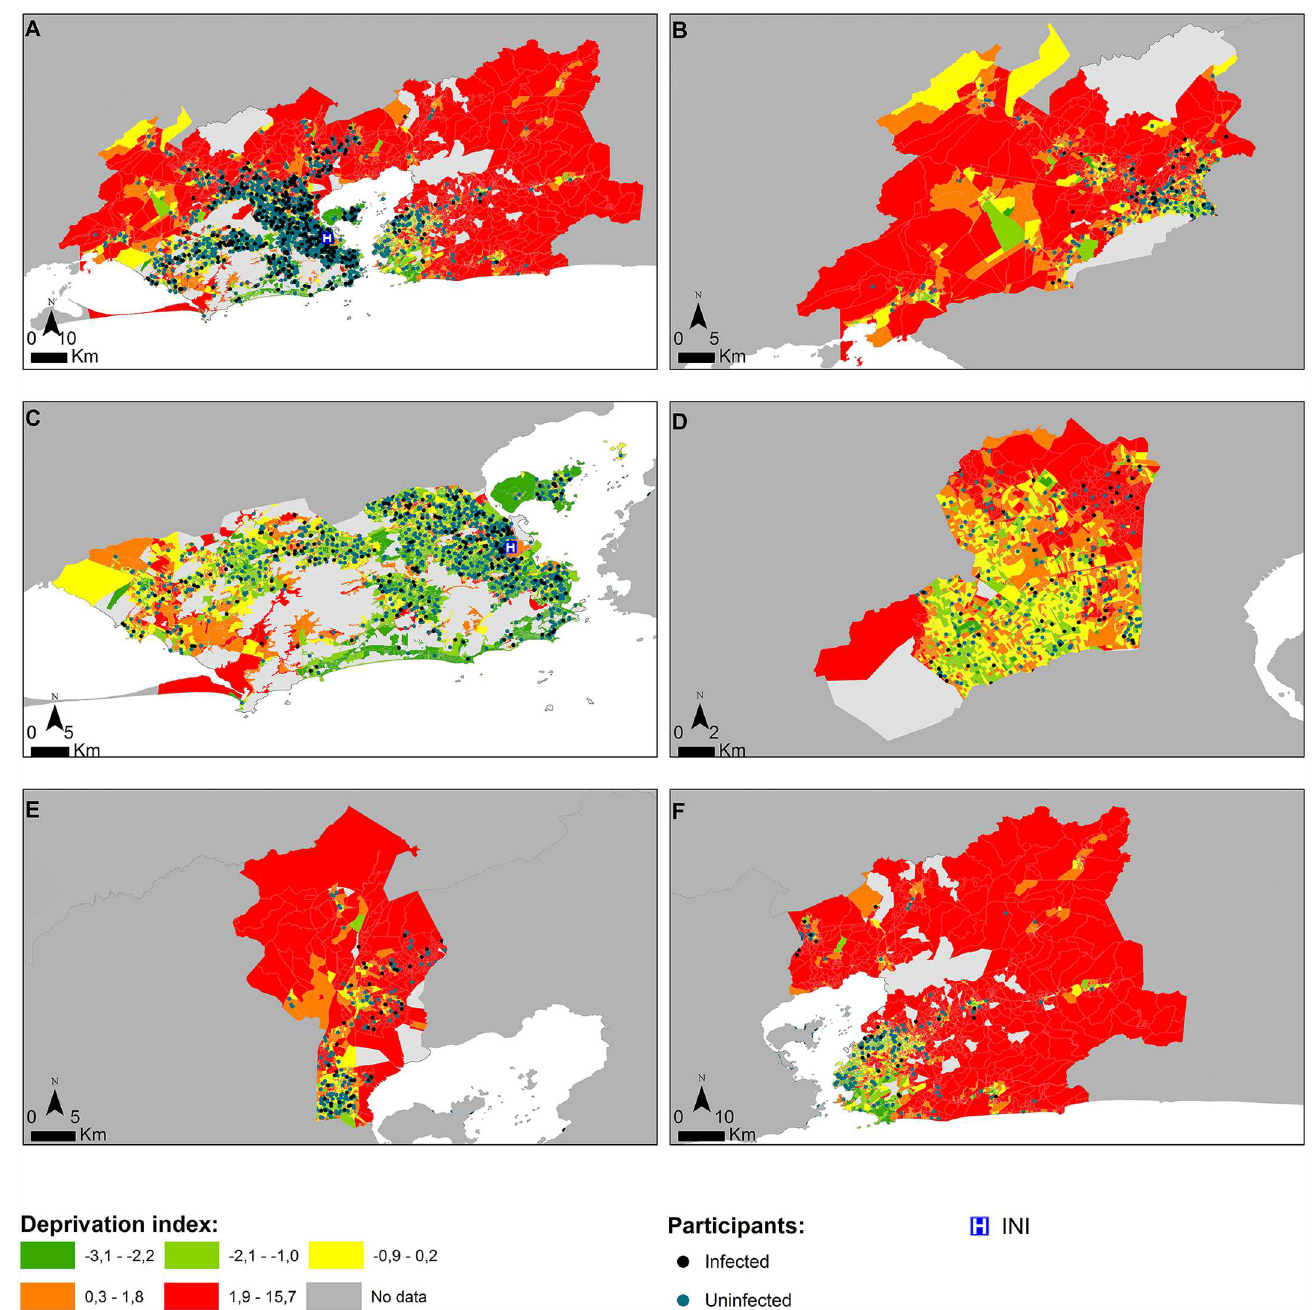
Fig 3. Geographical distribution of participants with and without intestinal parasitic infections and the Material Deprivation Index (MDIs). (A) Metropolitan regionof Rio de Janeiro; (B) Itaguaı´, Japeri, Queimados, Nova Iguac¸u, Paracambi and Serope´dica municipalities; (C) Rio de Janeiro municipality; (D) Belford Roxo, Mesquita,Nilo´polis and S ã o Jo ã ode Meriti municipalities; (E) Duquede Caxias municipality; (F) Cachoeirade Macacu, Guapimirim, Itaboraı´, Mage´, Marica´, Nitero´i, Rio Bonito, S ã o Gonc¸alo and Tangua´ municipalities(green (q1): lower material deprivation; red (q5): highermaterial